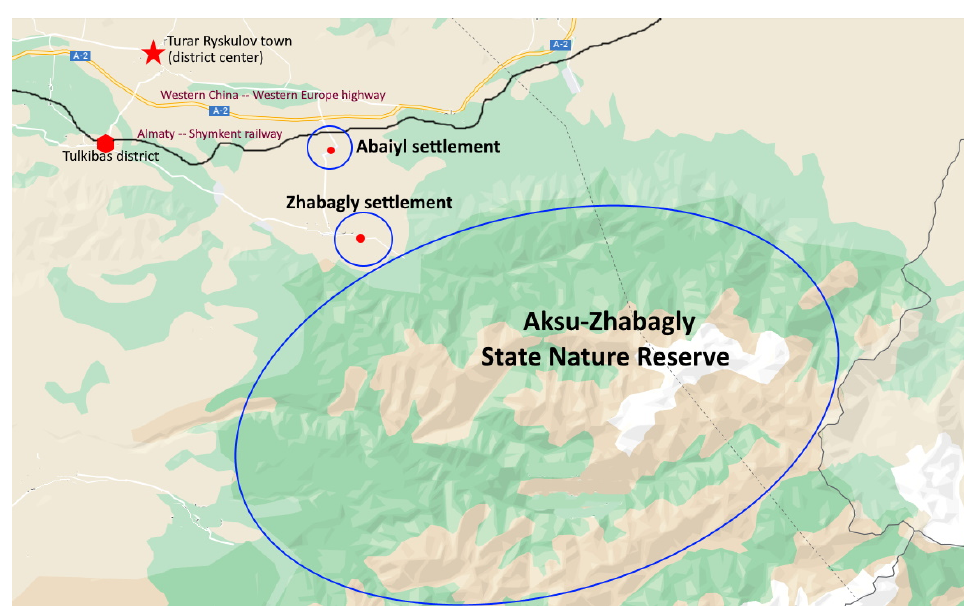
Figure 2: Zhabagly and Abaiyl community